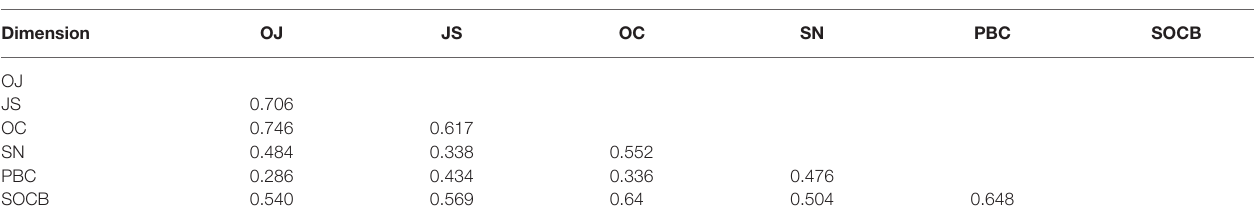
TABLE 4 | Heterotrait–Monotrait ratio of correlations (HTMT).